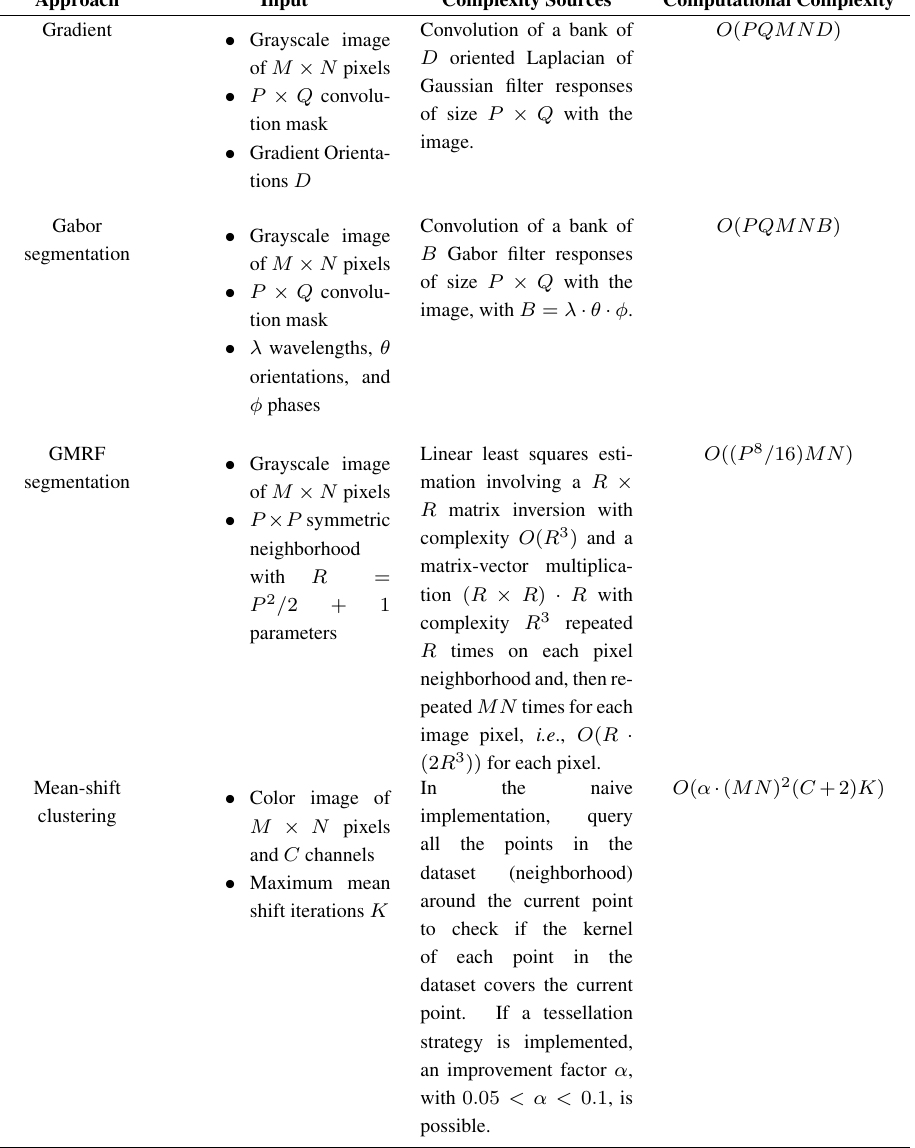
Table 5. Computational complexity of the different